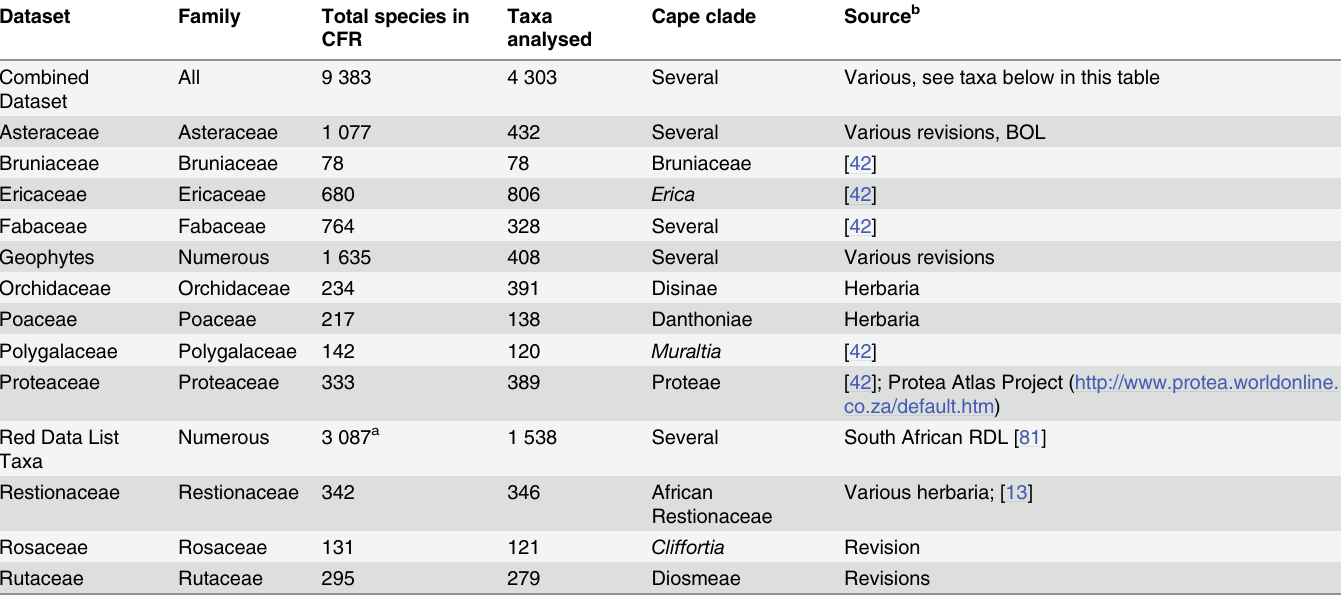
Table 1. The size of taxon datasets analysed in the